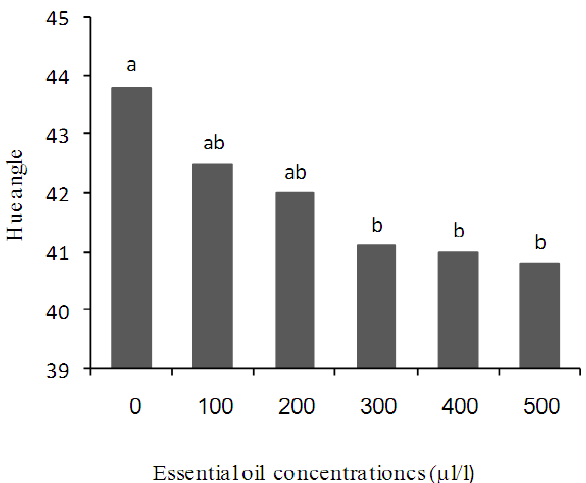
Fig. 6. The effect of essential oil treatment on hue angle of